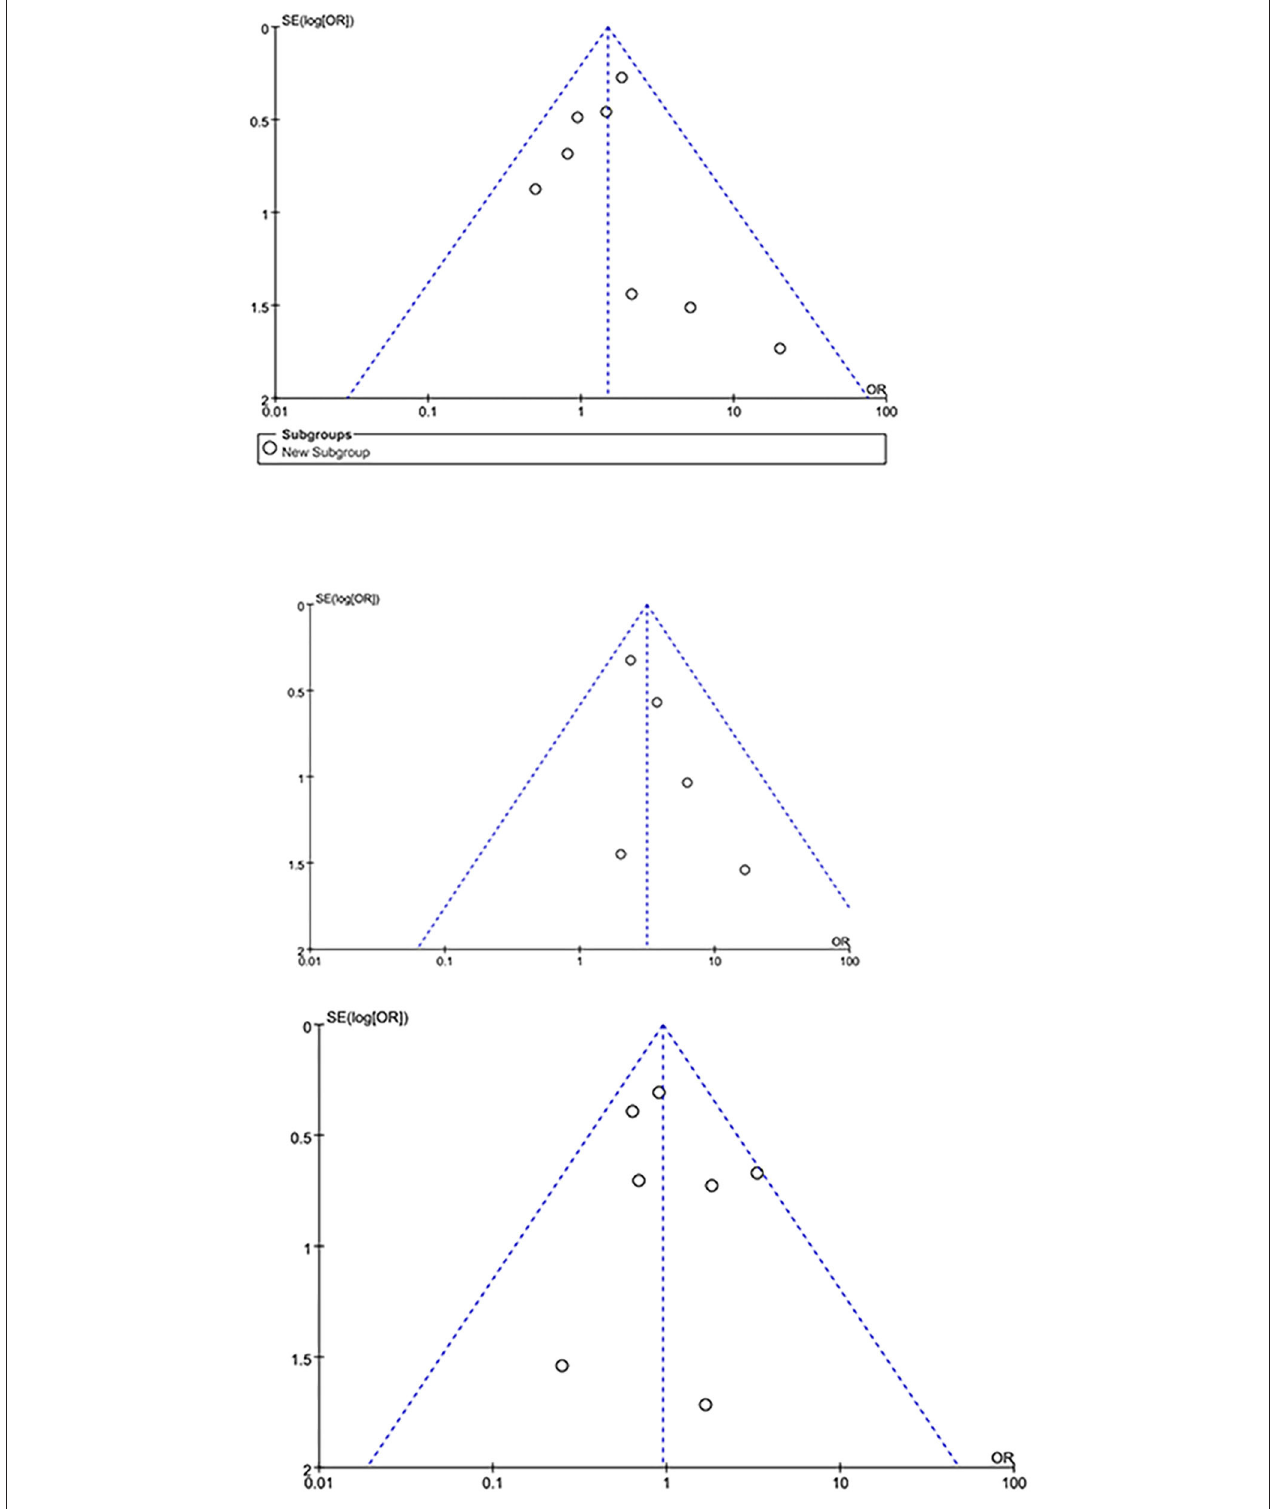
FIGURE 5 | The funnel plot for neurological dysfunction (above), cannulation-related complications (middle) and early mortality (below).